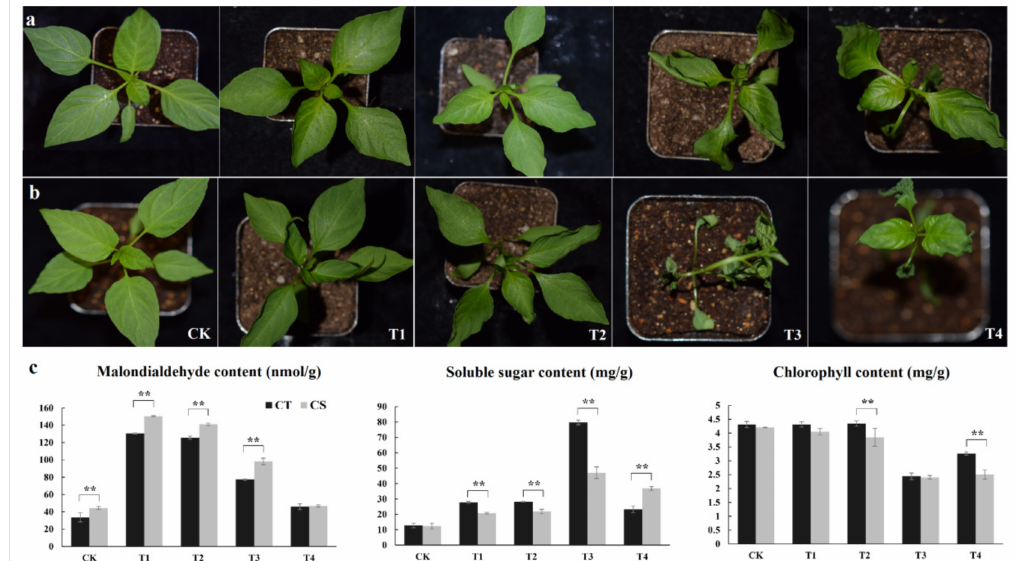
Figure 1. Phenotype and physiological indexes of pepper under cold–rewarm treatments. ( a ) Phenotype of CT in control, cold stress, and rewarming stage. ( b ) Phenotype of CS in control, cold stress, and rewarming stage. ( c ) Changes in malondialdehyde, soluble sugar (SS), and chlorophyll (Chl) content in the pepper leaves of both cultivars. ** indicate significant differences ( p ≤ 0.01).